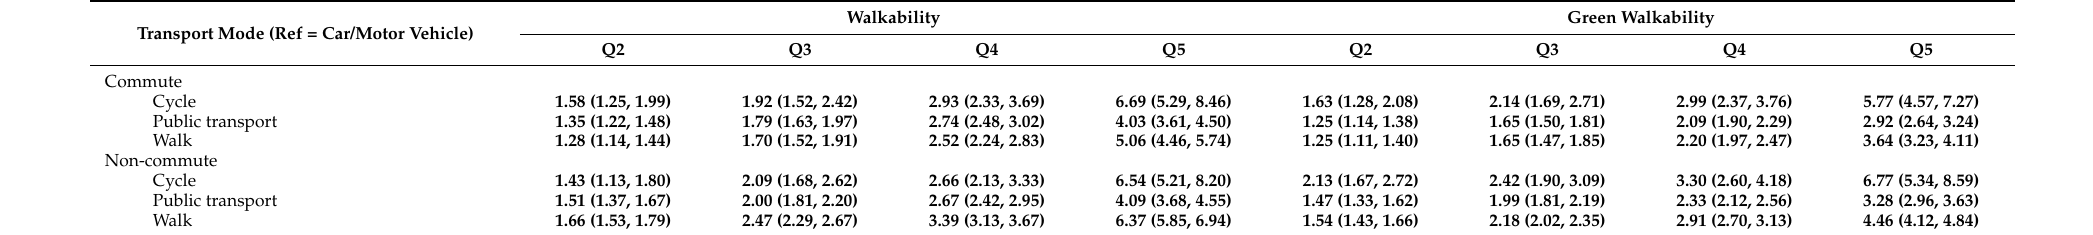
Table 4. Odds (risk ratio) and 95% confidence intervals (CIs) of active commute transport mode and active non-commute transport mode compared to using car/motor vehicle for commute ( n = 23,999) and non-commute ( n = 44,998) transport shown by quintiles of walkability and green walkability (Q1 being the lowest 20% of walkability scores; Q5 the highest 20%). Models were adjusted for: age, sex, average household income before tax, area-level deprivation level and distance between home and workplace (commute only). Bold font indicates p ≤